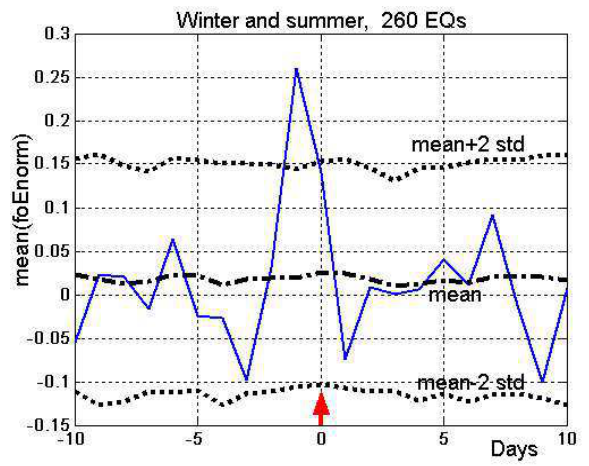
Fig. 1. Result of the superposition of epoches for the foE norm- values for earthquakes with M > 5 , R < 2000 km, and h < 60 km. The superposition time equals 20 days. The red arrow shows the day zero of the earthquakes. The mean value of foE norm ( i ) for the day i during seismo-active times is presented by the full blue line. The dash-dotted line designates the mean value of foE norm for all data considered. The dotted lines show the 95 %-interval of reliability obtained using the Monte-Carlo method.